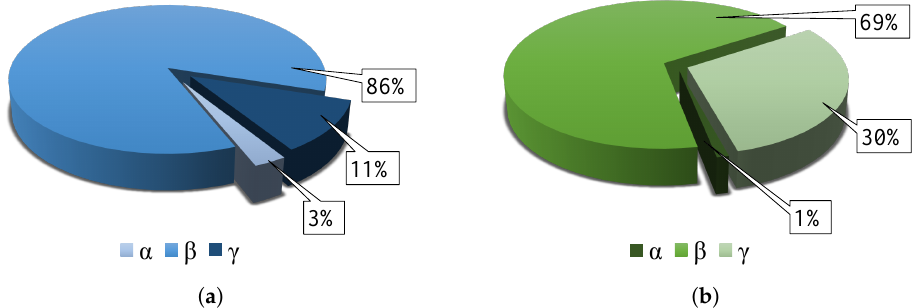
Figure 12. Comparison of calculated crystalline phase contents of ( a ) PVDF and ( b ) PVDF/PA6